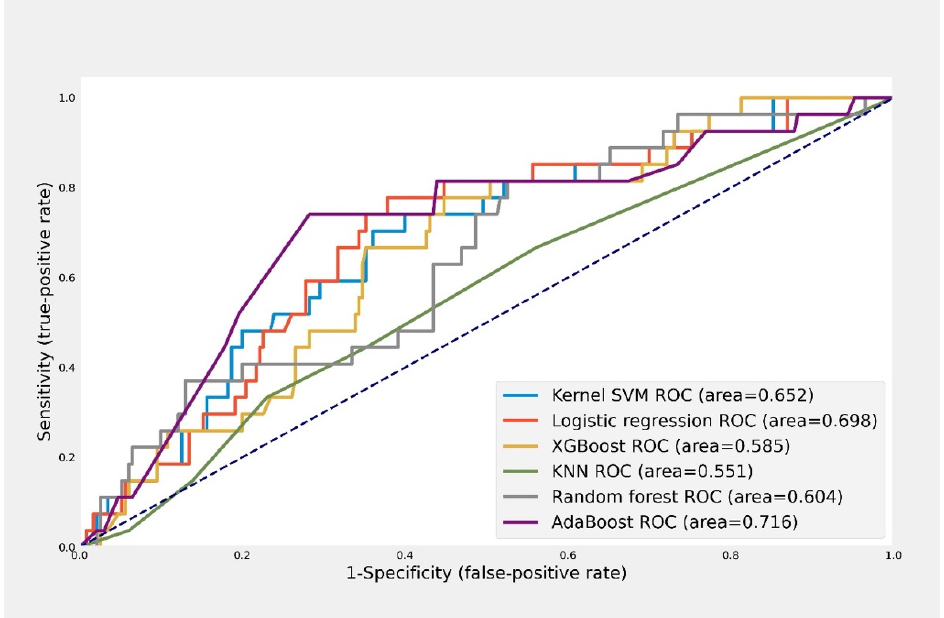
Figure 3. Receiver operating characteristic (ROC) curves of the ML models. Table 3. Cross-validation AUROC values of ML algorithms.